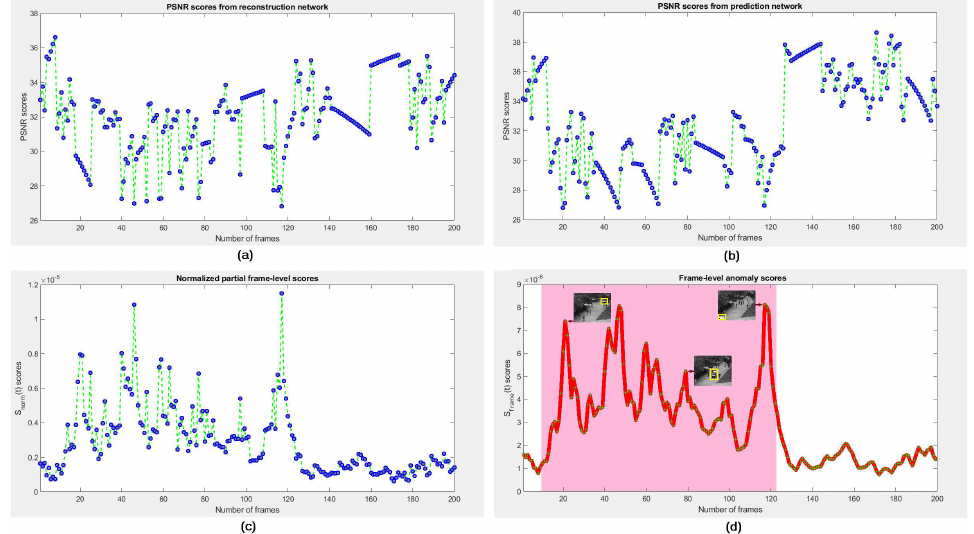
Figure 13. A sample output using UCSD-Ped1 [31], where a car anomaly was happened. ( a , b ) exhibit PSNR scores, whereas ( c , d ) show frame-level scores.